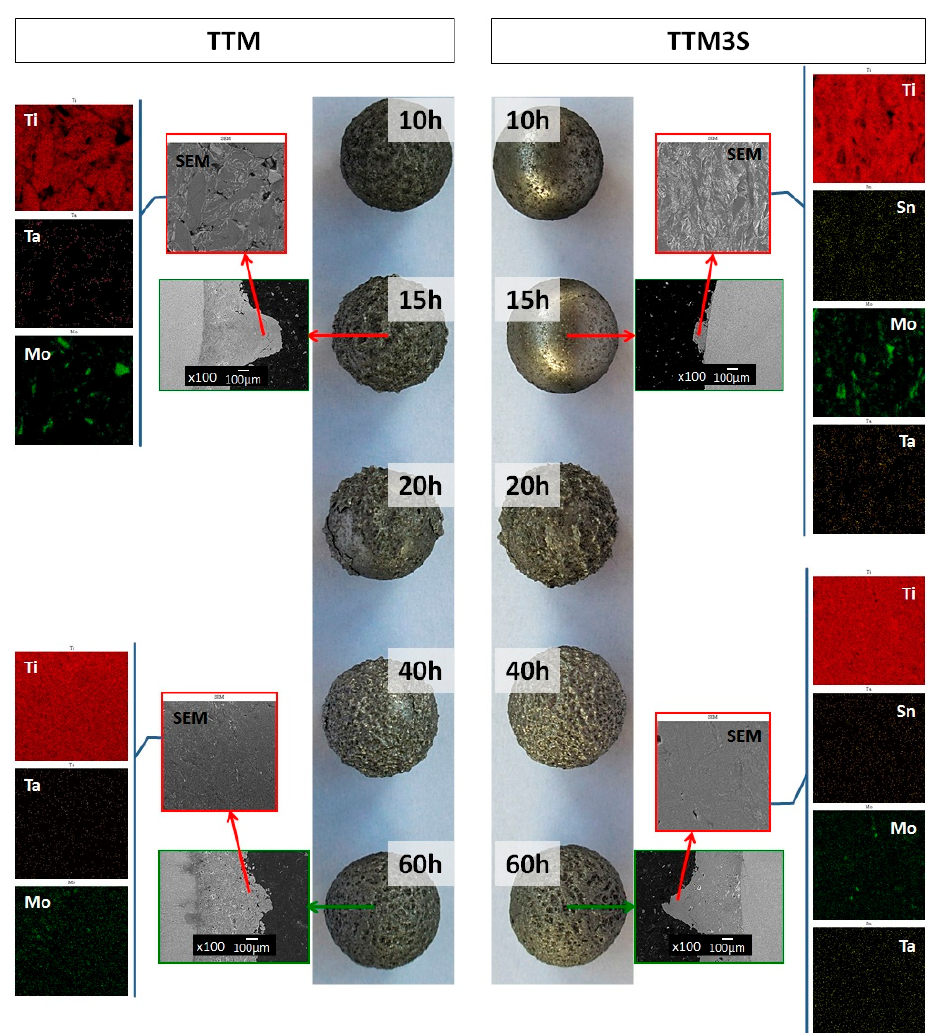
Figure 3. The balls and cross-sections of the balls with the milling product obtained during the milling process, with the distribution of Ti, Ta, Mo and Sn elements observed on the surface of the ball.